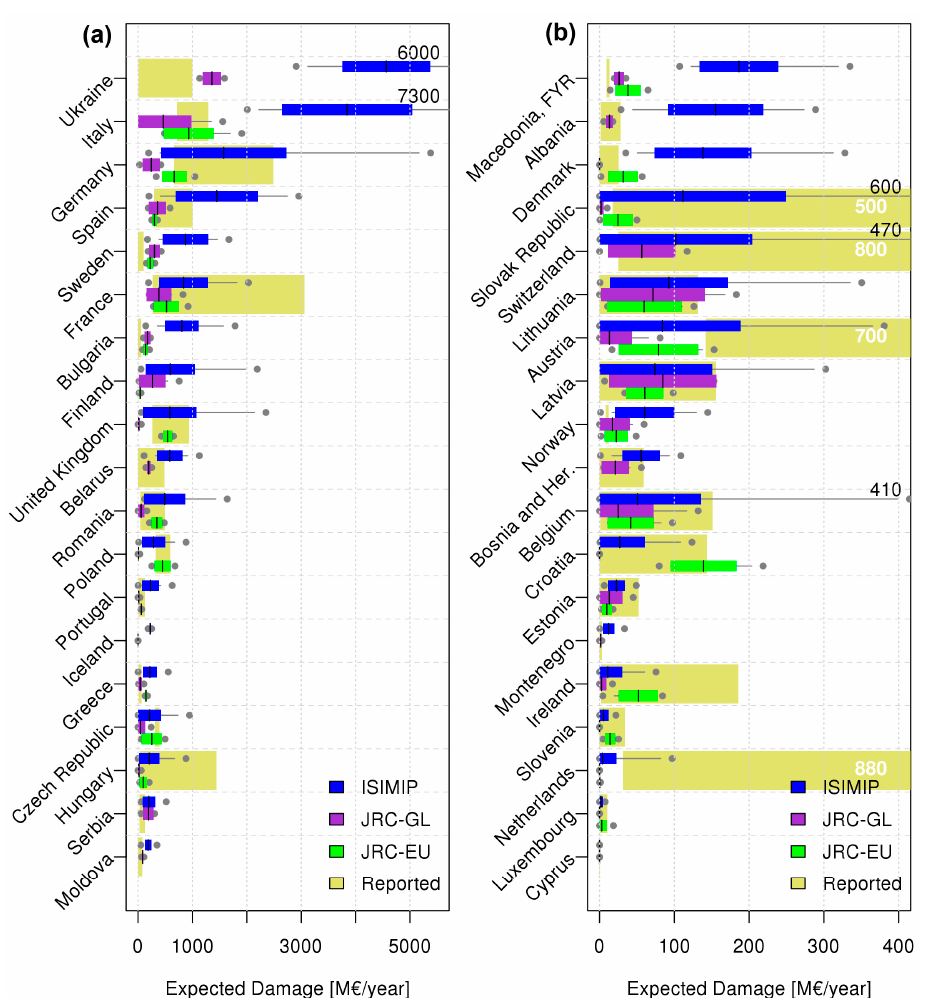
Figure 2. Economic damage computed for the baseline period for each country by the ensembles of the three case studies ( a , b ). Plots show the average (black dash), ± 1 standard deviation (colored bar), and minimum and maximum values (whiskers) of each ensemble. The gold bars show the range of reported impact values (minimum and maximum).